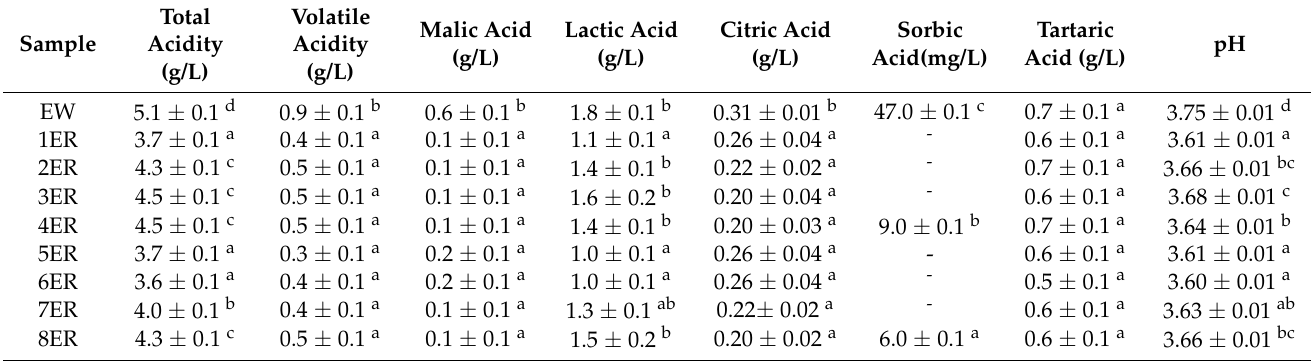
Table 6. Total acidity, volatile acidity, malic, lactic, citric, sorbic and tartaric acid and pH in the initial ecological Cabernet Sauvignon wine and the reverse osmosis retentates at 2.5, 3.5, 4.5 and 5.5 MPa, with cooling and without